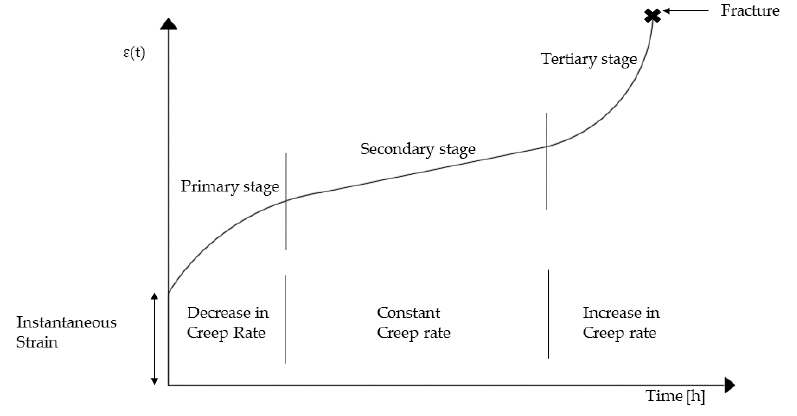
Figure 2. Creep curve under constant tensile load and constant temperature [22].